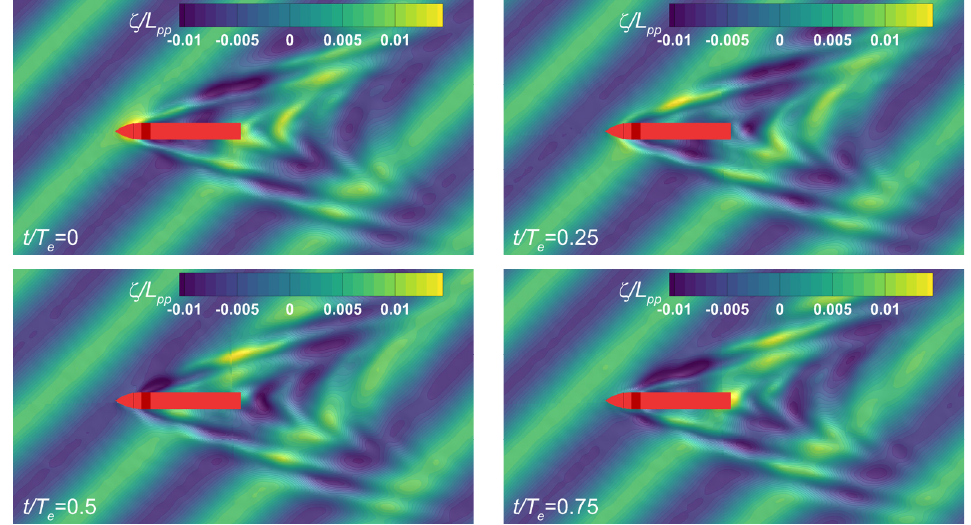
Figure 13. Free-surface elevations over a period of the bow wave encounter.